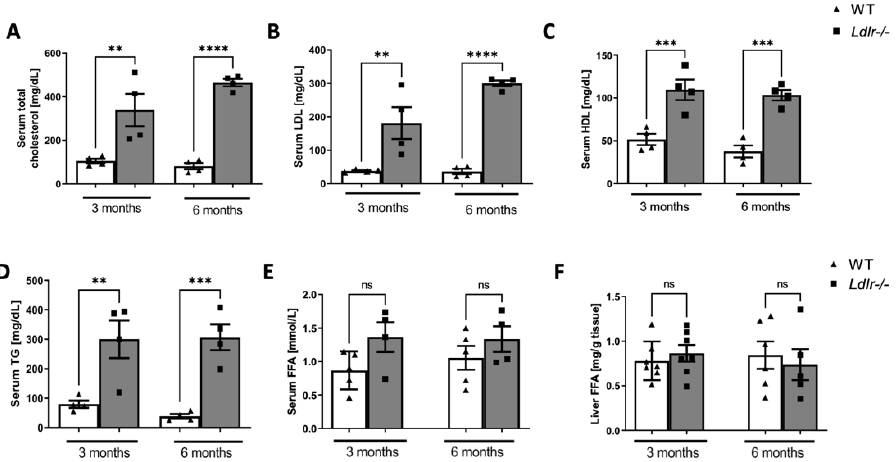
Figure 3. Serum and liver lipids in dyslipidemic Ldlr−/− mice. Serum total cholesterol ( A ), LDL cholesterol ( B ) HDL cholesterol ( C ), and triglycerides ( D ) concentration in wild-type (WT) and dyslipidemic ( Ldlr−/− ) mice. Free fatty acids (FFA) in serum ( E ) and liver ( F ) of WT and Ldlr−/− mice, n = 4–6; ns, non-significant; ** p < 0.01; *** p < 0.001; **** p < 0.0001.